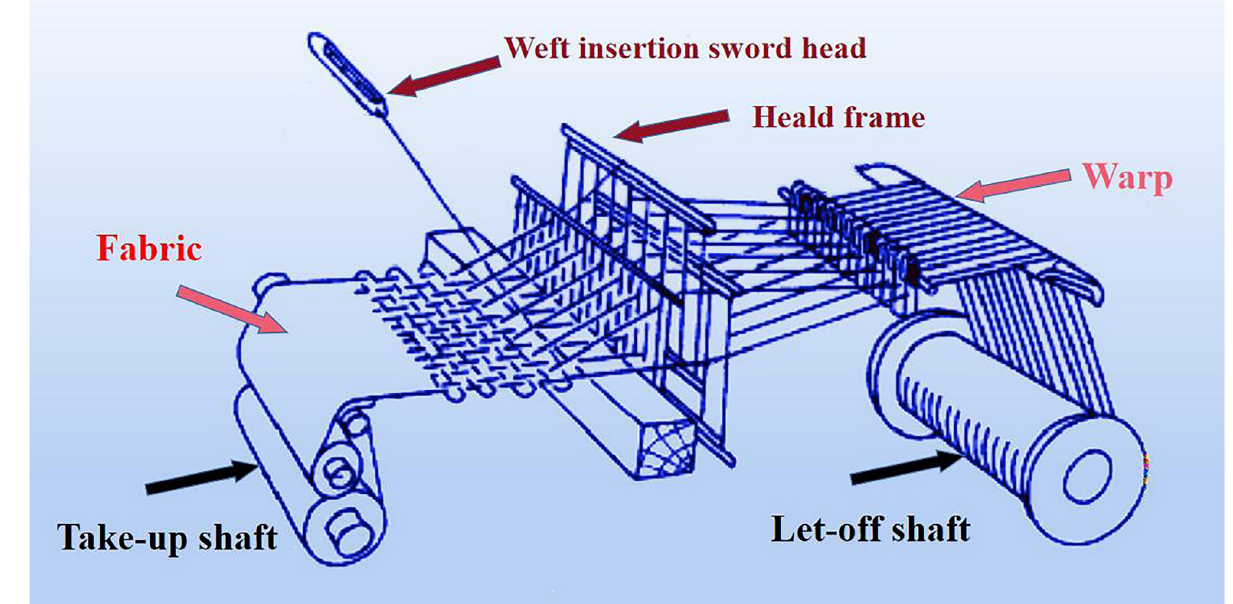
Fig 2. Schematic diagram of rapier loom fabric